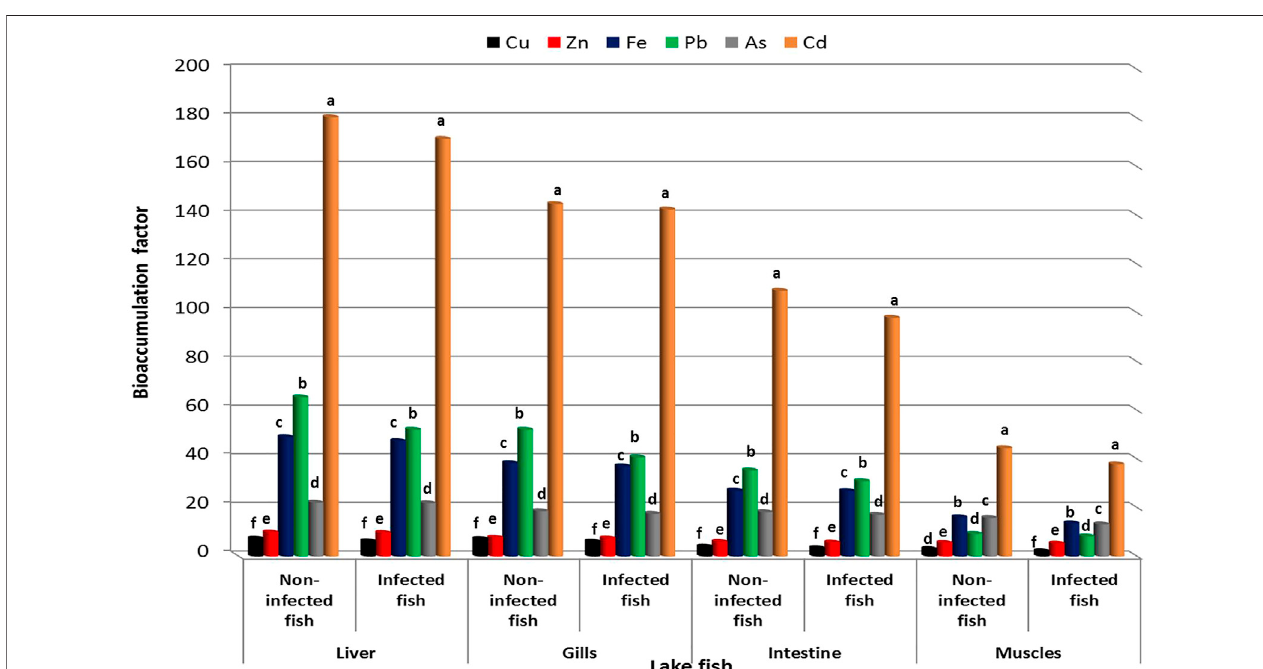
FIGURE 4 | Bioaccumulation factor of heavy metals in different organs of lake Nile Tilapia, O. niloticus .